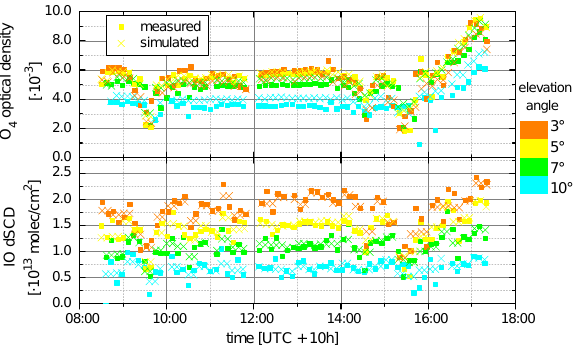
Fig. 3: Averaging kernels for inferred AOD and IO , both averaged for the data from all Fig. 3. Averaging kernels for inferred AOD and IO, both averaged profile retrievals. for the data from all profile retrievals.